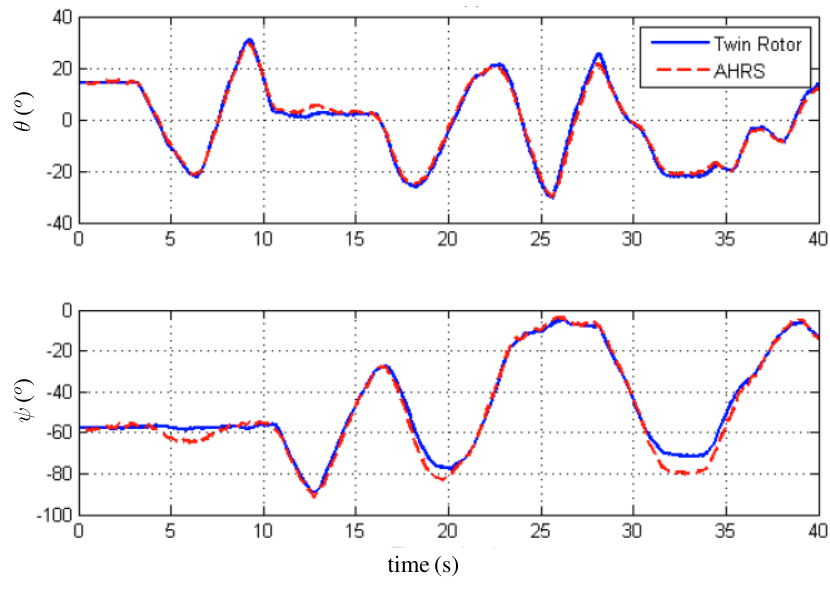
Figure 7. Estimation of θ (pitch) and ψ (yaw) angles.